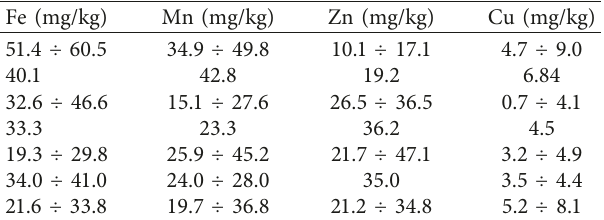
Table 2: Contents of microelements in grains of wheat ( Triticum aestivum L.) (according to Tekli´c et al. [64]).